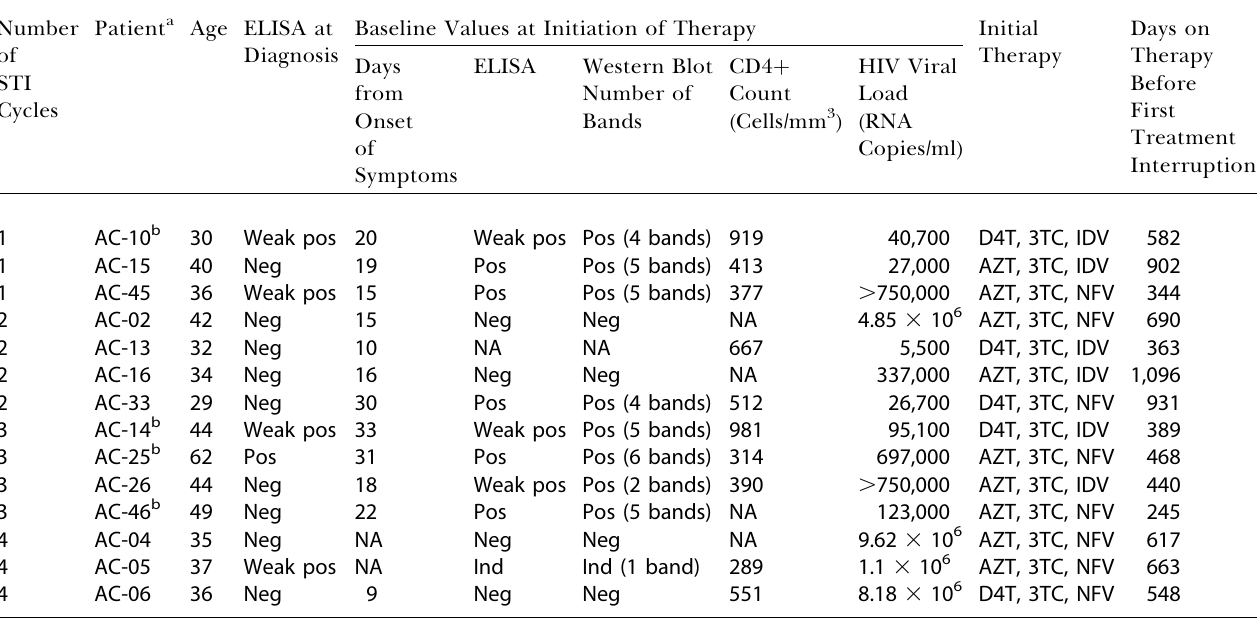
Table 1. Characteristics of the Study Participants Baseline Values at Initiation of Therapy Initial Days Patient a Age ELISA at Number Diagnosis of STI Cycles